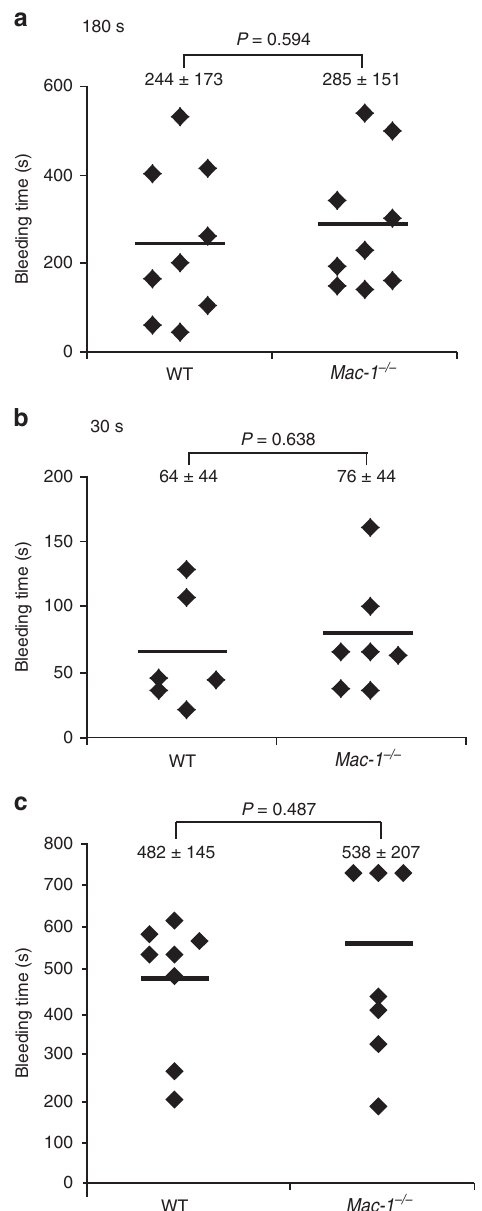
Figure 5 | Deficiency of Mac-1 has no effect on tail bleeding time. To assess the role of Mac-1 in haemostasis, tail bleeding times were determined in 2- to 3-month-old WTand Mac-1 (cid:2) / (cid:2) male and female mice using two methods. Method 1: the transected tail tip was placed into a beaker containing saline and the time for complete cessation of bleeding either for 3min ( a ) or 30s ( b ) was recorded. Method 2: the transected tail tip was blotted with filter paper and the time to complete cessation of bleeding was recorded ( c ). Mean ± s.d. ( n ¼ 6–9 per group, each dot represents one data point from one single mouse). P values are obtained by unpaired two-tailed t-